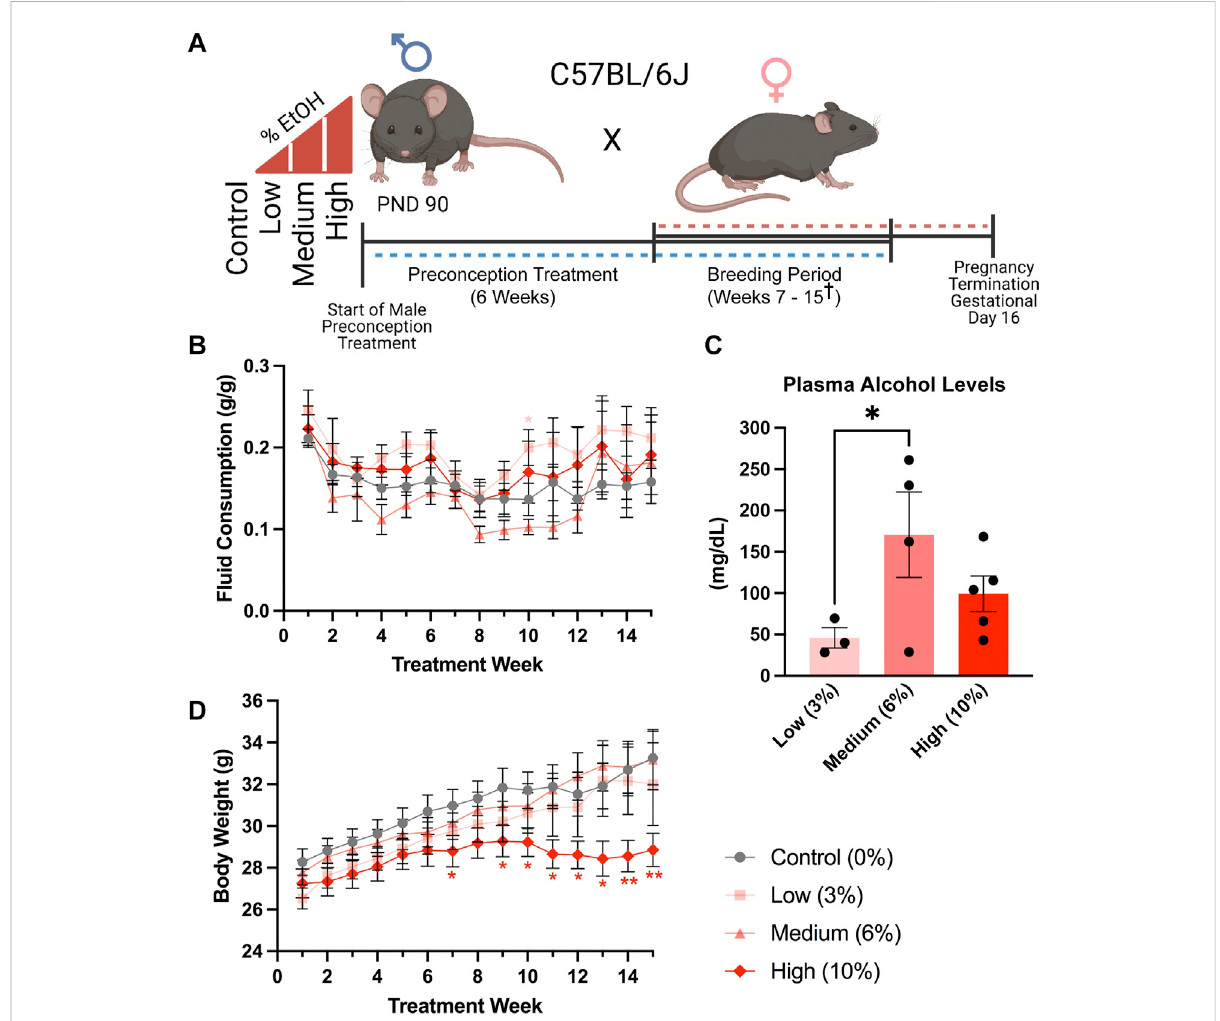
FIGURE 1 A limited access model to study concentration-dependent, ethanol-induced changes in paternal epigenetic programming. (A) Schematic outline of the experimental approach used to model the impacts of increasing ethanol concentrations on offspring fetoplacental growth. The preconception exposure period lasted 6 weeks, with exposures continuing during the breeding phase, which lasted from weeks seven and fi fteen ( † oneControl,twoMedium-andtwoHigh-concentrationlittersweresiredbetweenweekssixteenandeighteen). (B) Fluidconsumptionpatterns compared between the different treatment groups ( n = 17 Control, 13 Low, 12 Medium, 13 High). (C) Comparison of average plasma alcohol levels between treatment groups, measured after 3 weeks of exposure, at the end of the daily treatment window ( n = 3 Low, 4 Medium, 5 High). (D) Comparison of sire body weight throughout the 10-week preconception exposure window ( n = 17 Control, 13 Low, 12 Medium, 13 High). We used one-way (C) and two-way ANOVAs (B,D) to assay differences between treatment groups. Error bars represent the standard error of the mean, * p < 0.05, ** p <